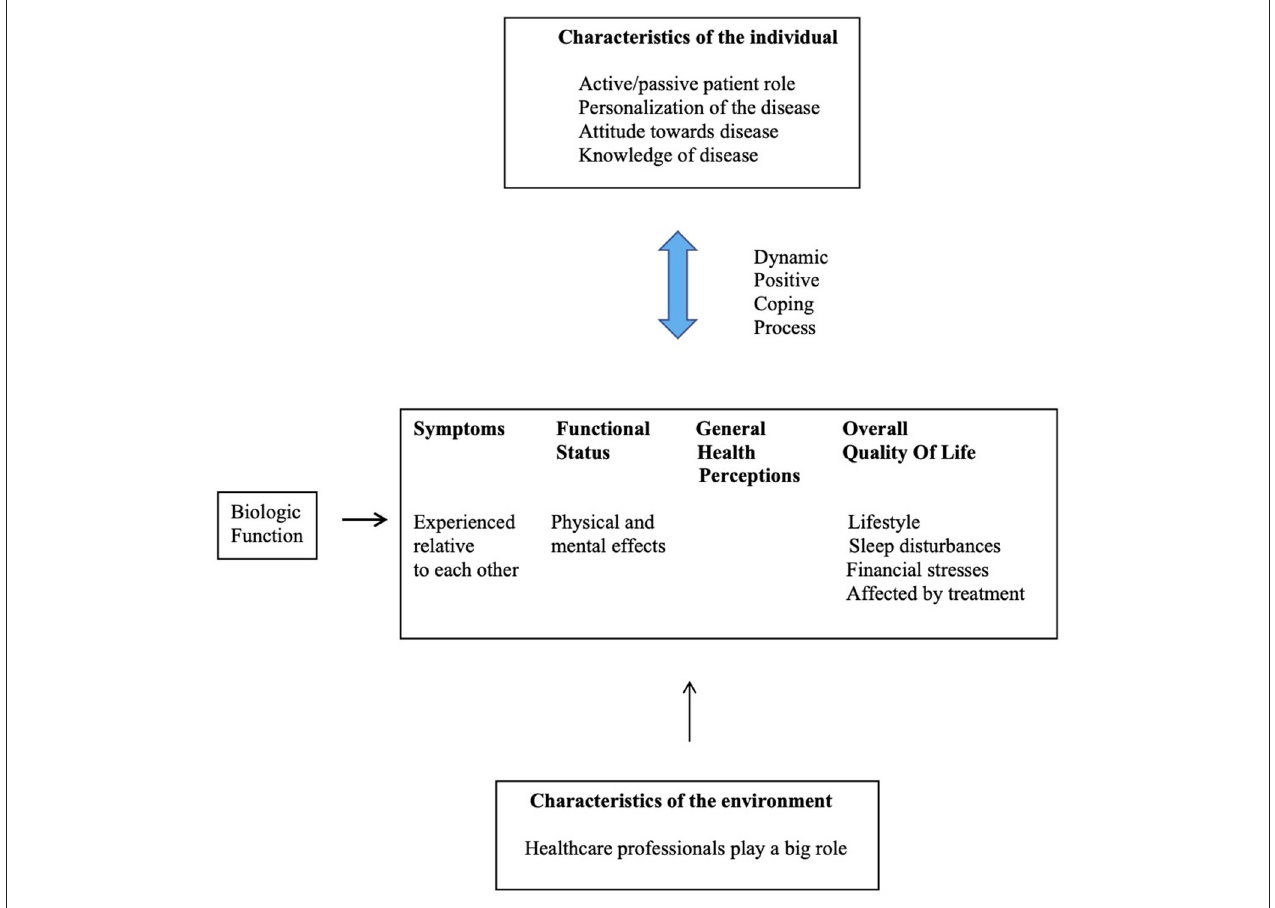
FIGURE 2 | Adapted from [10]: The participants’ view of the model of Ferrans et al. [47].